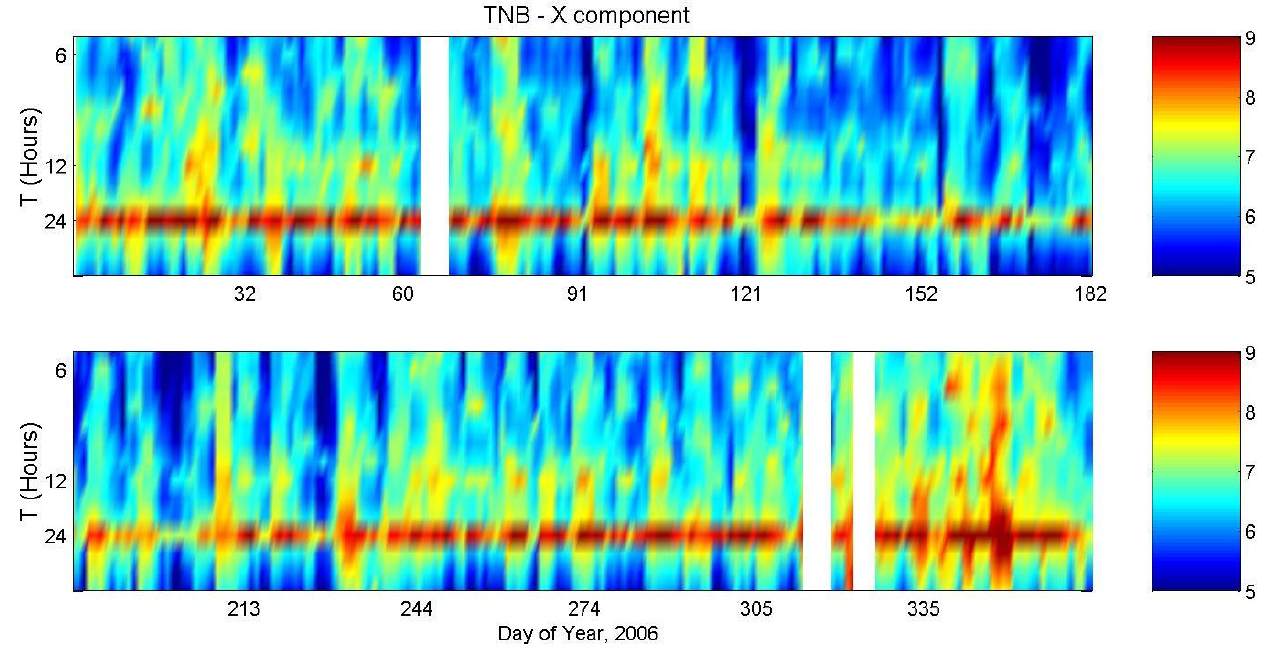
Fig. 3. Dynamic spectrum (a.u.) of the X component at TNB during 2006.